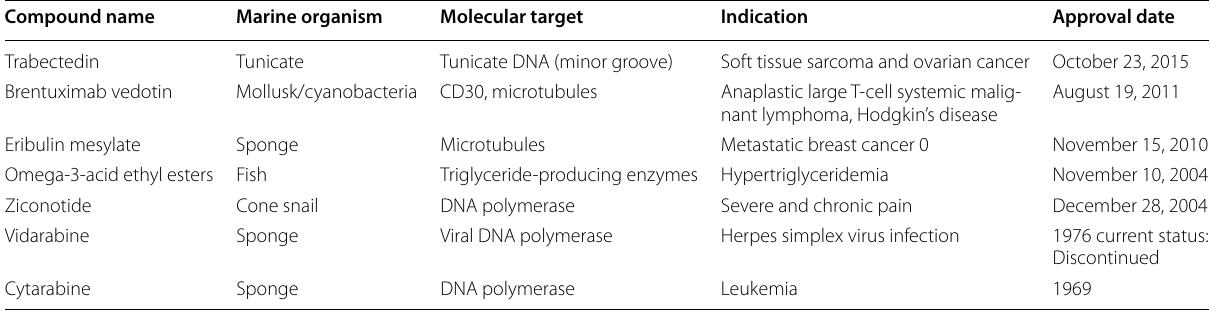
Table 1 List out some of U.S FDA approved clinical drugs for various human diseases obtained from marine